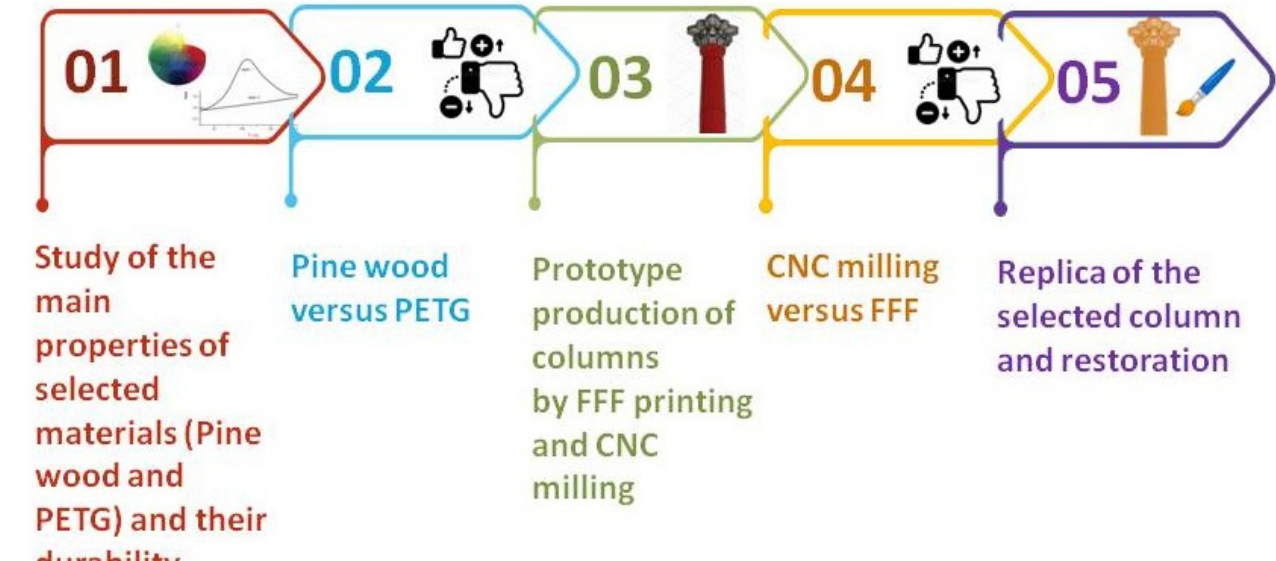
Figure 2. Experimental activity in summary.